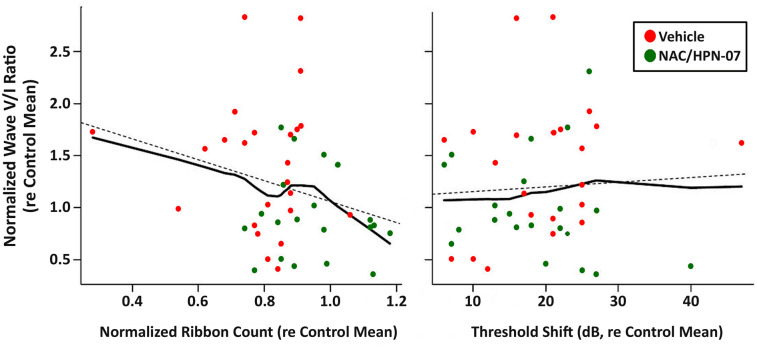
Tinnitus-related enhancement of ABR wave V/I ratios correlated with IHC de-afferentation.Loess regression suggested that the enhancement of the wave V-to-wave I ratio after blast injury is likely due to loss of cochlear synapses rather than damage to cochlear sensory cells (see Results). Loess curves were fitted to the empirical data in a scatterplot of wave-V/I ratio vs. either ribbon count (A.) or threshold shift (B.) with a smoothing span = 0.75 and a polynomial degree = 2 (quadratic). ABR wave-V/I ratios and ABR threshold shifts, as well as IHC presynaptic ribbon counts, were averaged in blast-exposed ears from each vehicle (red dots)- or therapeutic (green dots)-treated animal (n = 44) for frequencies from 4–32 kHz and then normalized to mean values from naïve, unexposed control ears (n = 12). Data were obtained at 8–9 weeks after blast exposure. Loess curves and linear trendlines (that the loess fit captures in the data) were depicted by solid lines and dashed lines, respectively.